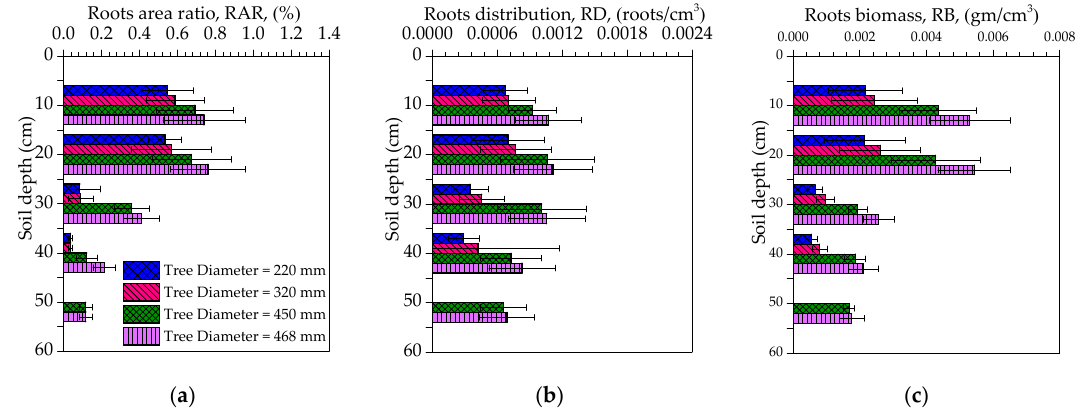
Figure 7. Variation of roots indices with depth ( a ) roots area ratio (RAR) ( b ) roots distribution (RD), and ( c ) roots biomass (RB).